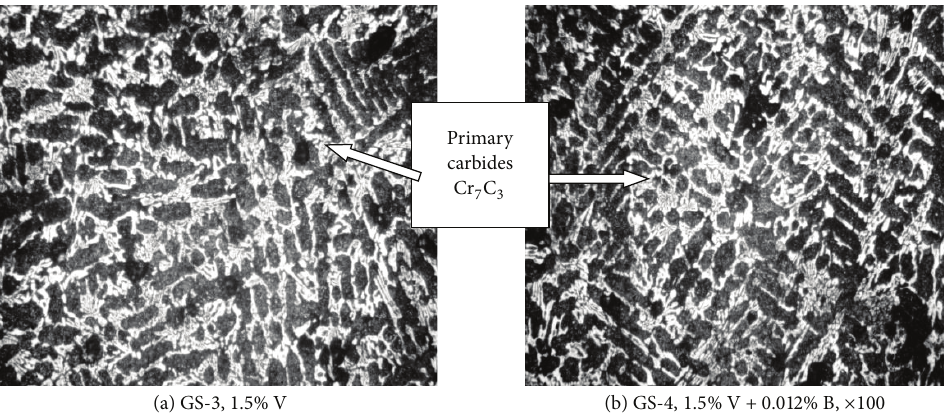
Figure 4: As-cast microstructure of GS-3 and GS-4 experimental